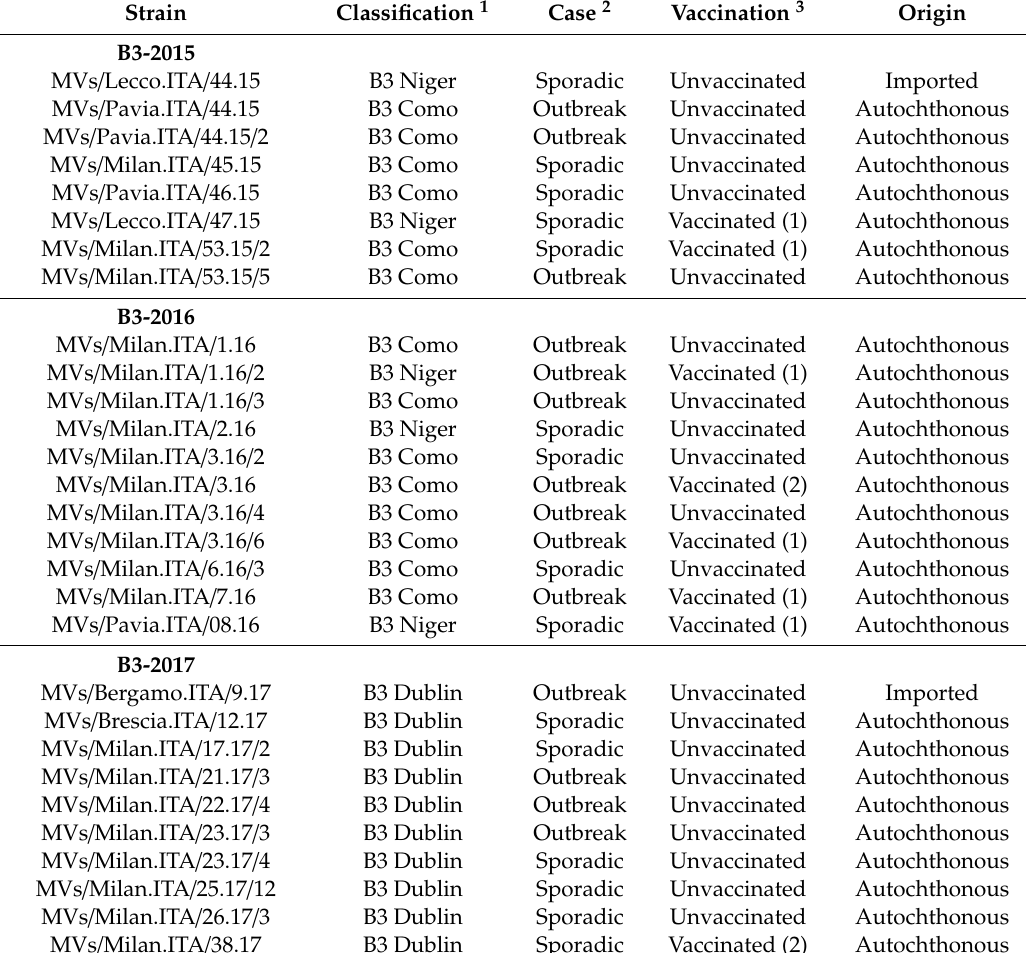
Table 1. Origin and classification of measles virus (MV) strains circulating in Lombardy in 2015–2019 and epidemiological characteristics of associated